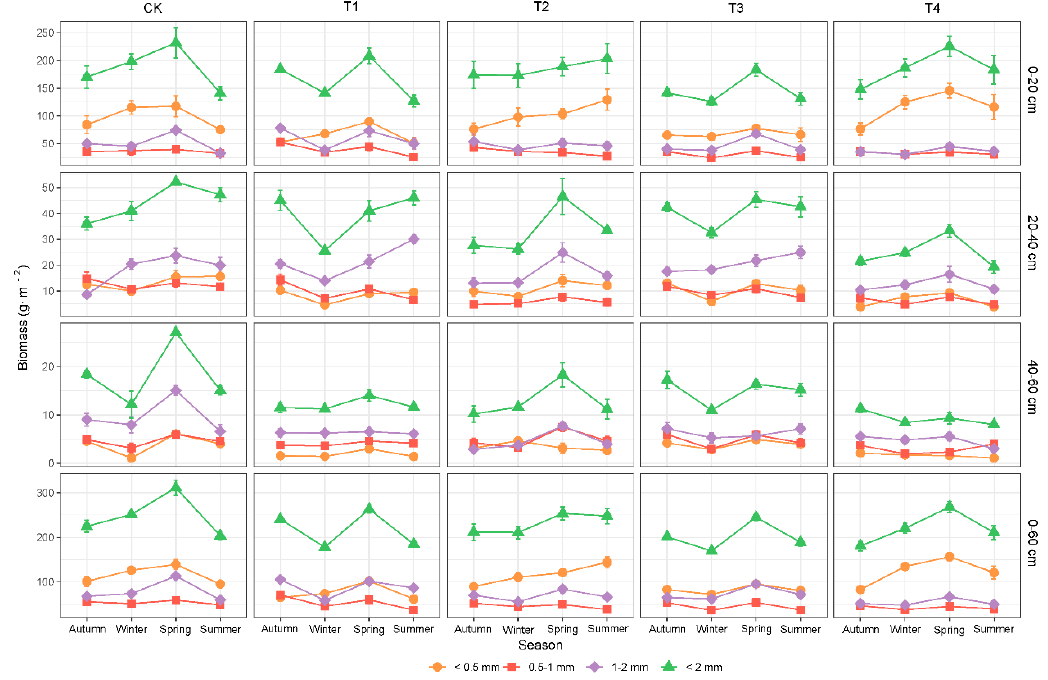
Figure 3. The effects of the season on the fine-root biomass (live) among different diameter classes in different soil depths, and the entire soil profile. The values are the mean of four replicates ± SE. CK, T1, T2, T3, and T4 represent 0%, 15%, 30%, 45% and 60% thinning intensities, respectively.